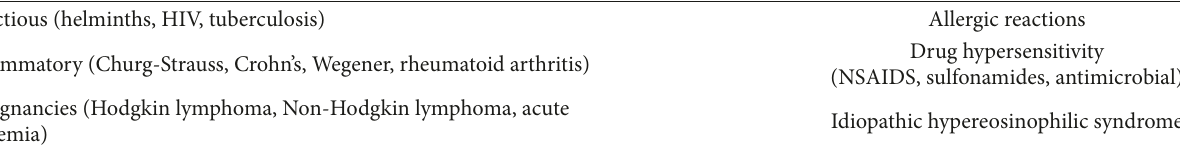
Table 3: Causes of